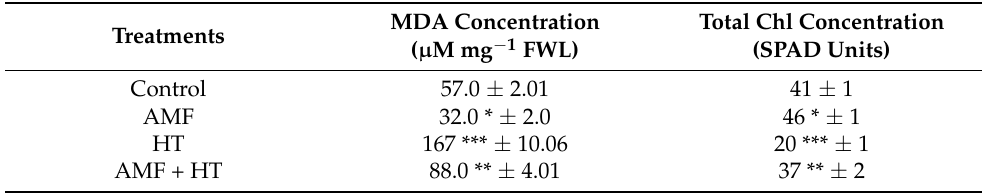
Table 2. Malondialdehyde (MDA) content ( µ M mg − 1 FWL) and total chlorophyll content in maize